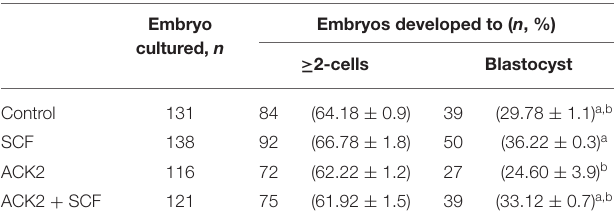
TABLE 2 | Effect of stem cell factor (SCF)/c-kit signaling during porcine in vitro maturation (IVM) on embryonic development after in vitro fertilization (IVF). Embryo Embryos developed to ( n , %) cultured, n ≥